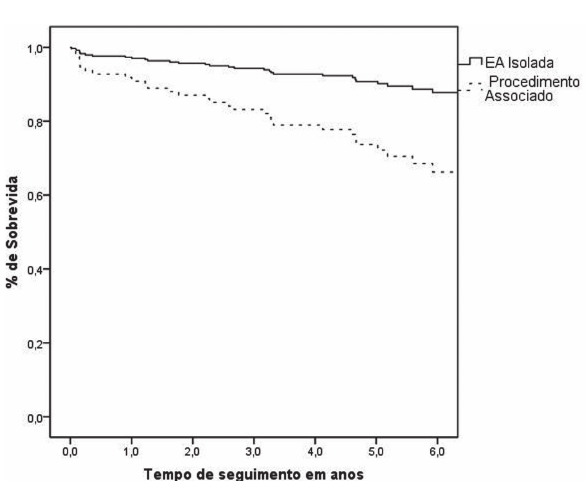
Fig. 3. Mortalidade por causas cardiovasculares após a alta hospitalar, de acordo com o período de tempo estudado. EA = estenose aórtica